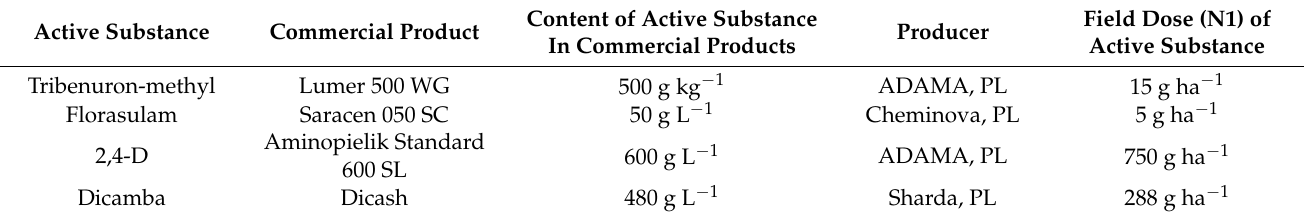
Table 1. Description of herbicides used in the biological